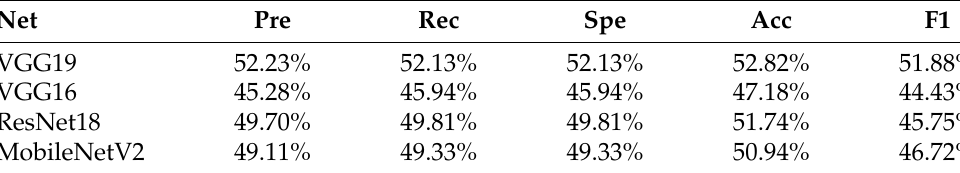
Table 4. Macro-average performance for testing on COVID-CT without fine-tuning.